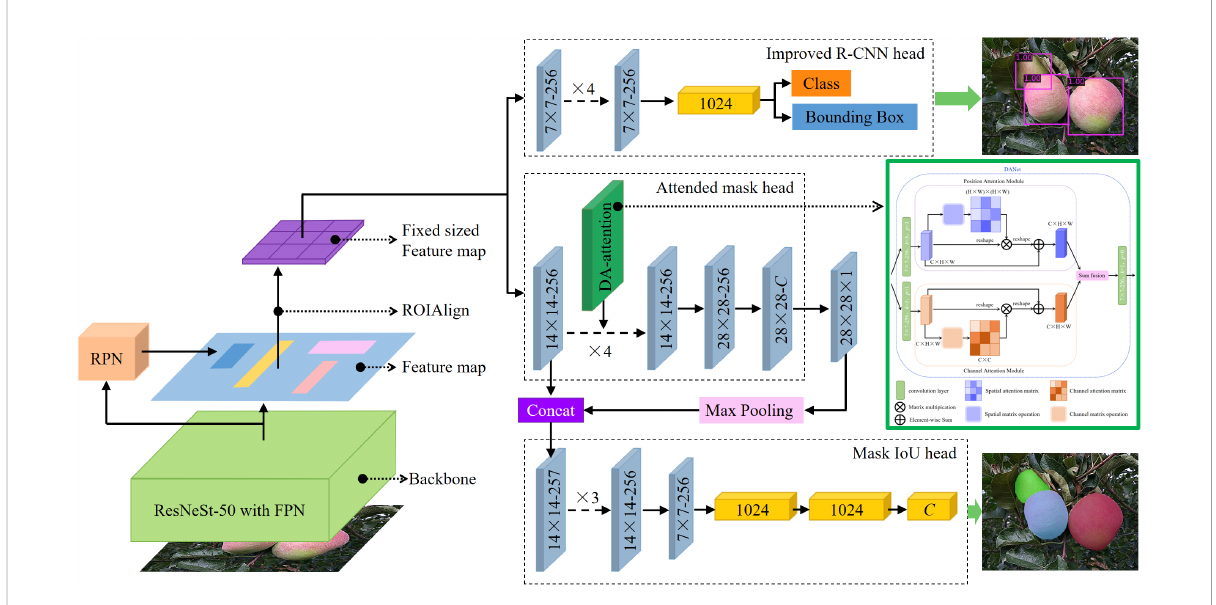
FIGURE 1 Structure of MS-ADS network. 1. Input images into backbone for feature extraction. 2. Input obtained feature maps into RPN and RoIAlign. 3. Fed acquired feature maps into R-CNN head for classi fi cation and bounding box regression, and into attended mask head and Mask IoU head for apple instance